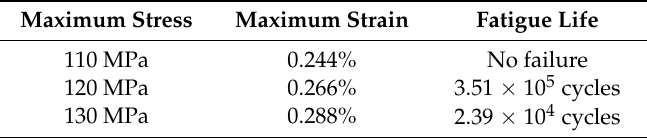
Table 1. Fatigue testing results at three stress amplitudes.